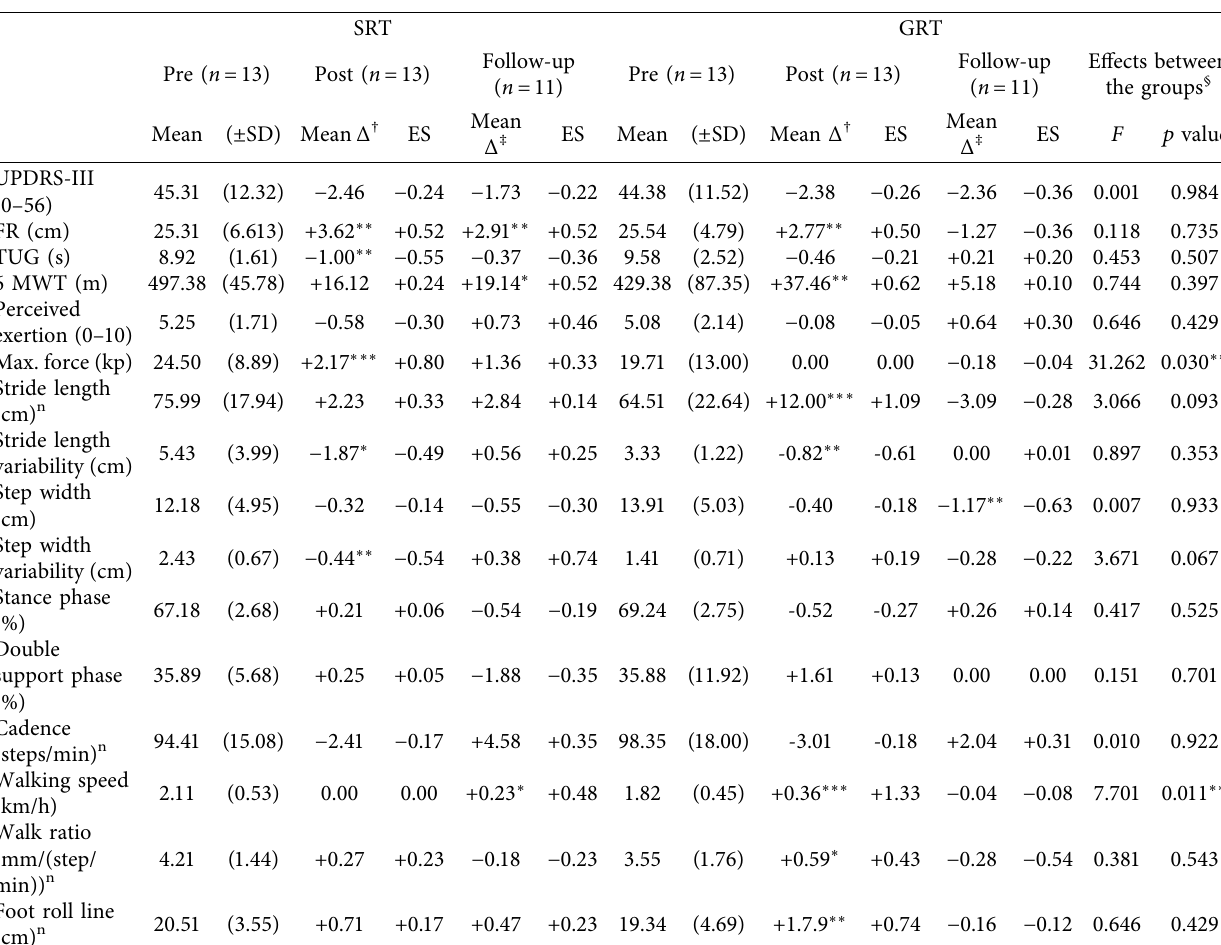
Table 2: Comparison of the effects of stability resistance training and gait resistance